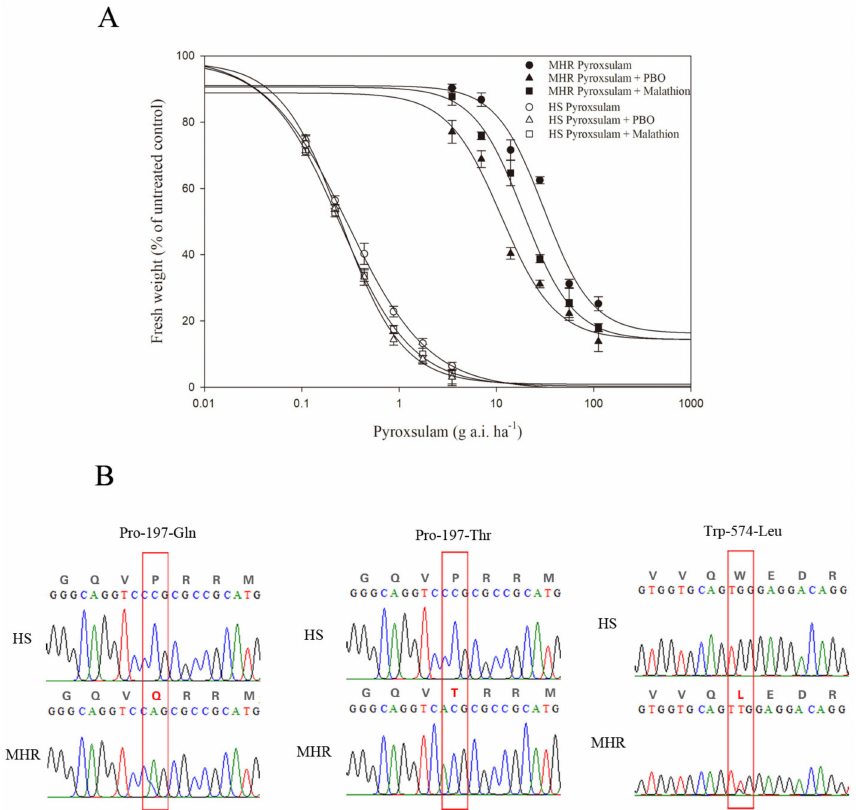
Figure 2. The MHR population has resistance to ALS-inhibiting pyroxsulam. ( A ) Percentage fresh weight with application of pyroxsulam and P450 inhibitors in the whole-plant dose–response assay. ( B ) Mutations in the ALS gene. Vertical bars represent the mean ± SE. Amino acid sequence positions refer to the sequence of ALS from Arabidopsis thaliana (GenBank accession number NM_114714). Non-synonymous mutations are marked with red